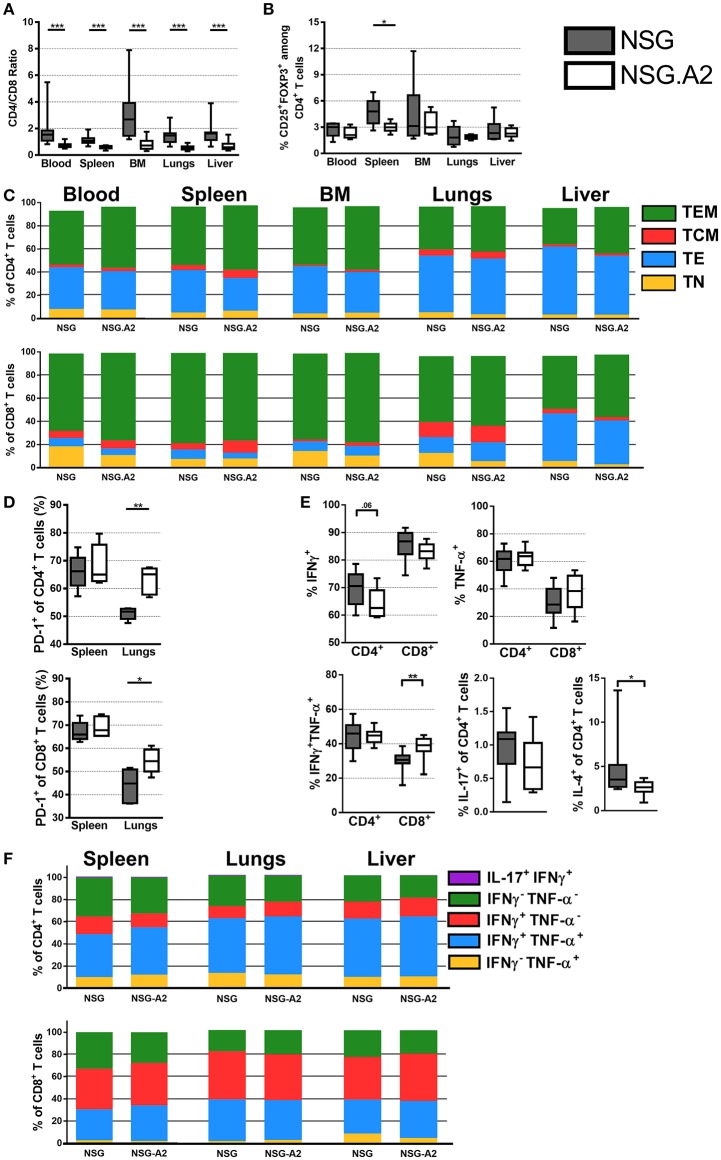
Differentiation and phenotype of human T cells in NSG and NSG-HLA-A2/HHD mice transplanted with HLA-A2 PBMCs. NSG and NSG-HLA-A2/HHD (NSG.A2 in figure) mice were transplanted with HLA-A2+ PBMCs and were sacrificed at day 14 to collect their organs and perform flow cytometry analyzes. (A) CD4/CD8 ratio in indicated organs (11–12 mice/group). (B) Frequency of Treg in the different organs (11–12 mice/group). (C) Mean frequency of naive (TN, CD45RA+CD27+), effector (TE, CD45RA−CD27−), central memory (TCM, CD45RA−CD27+CD62L+) and effector memory (TEM, CD45RA−CD27+CD62L−) T cells (11–12 mice/group). (D) Frequency of PD-1+ T cells in spleen (5 mice/group). (E) Frequency of IFNγ+, TNF-α+, IFNγ+TNF-α+, IL-4+, and IL-17+ T cells in spleen (11 mice/group). (F) Mean frequency of IFNγ−TNF-α+, IFNγ+TNF-α+, IFNγ+TNF-α−, IFNγ−TNF-α−, and IL-17+IFNγ+ T cells (5 mice/group). Data in A, B, D, and E show the median, 25 and 75th percentiles of the distribution (boxes), and whiskers extend to the 5 and 95th percentiles (*p < 0.05, **p < 0.005, ***p < 0.0005).